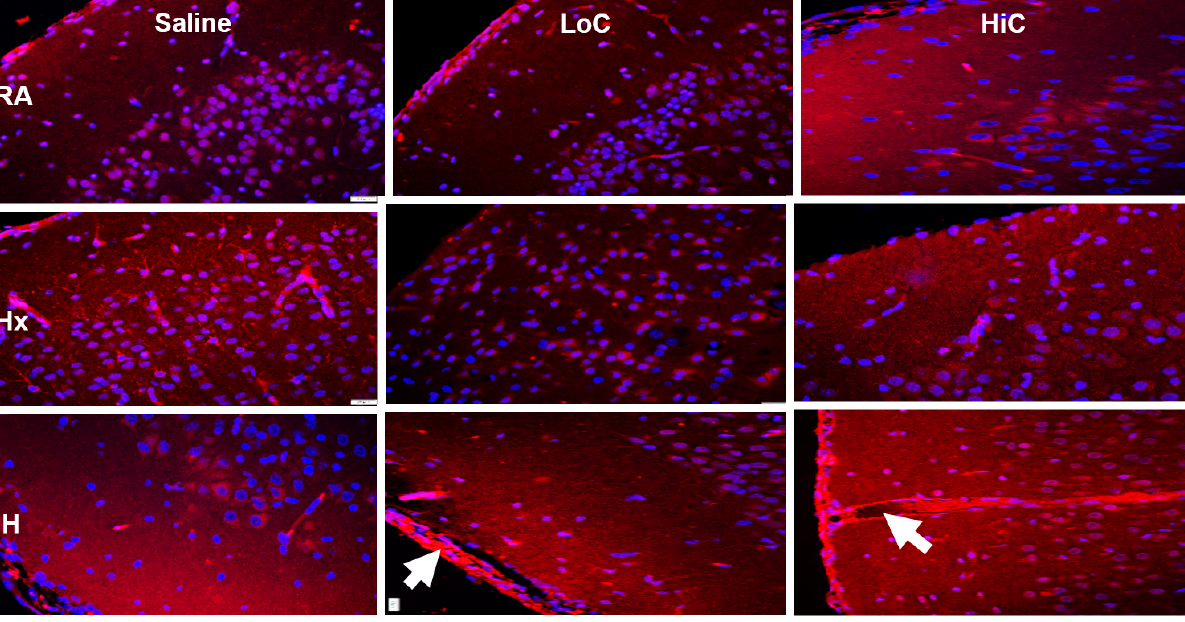
Figure 6. Representative caspase-9 immunofluorescence staining in the cerebral cortex at P14. Groups are as described in Figure 1. Images are 20 × magnification, bar scale is 50 µ m. LoC in IH showed mild hemorrhage (arrow). HiC induced caspase-9 only in neonatal IH